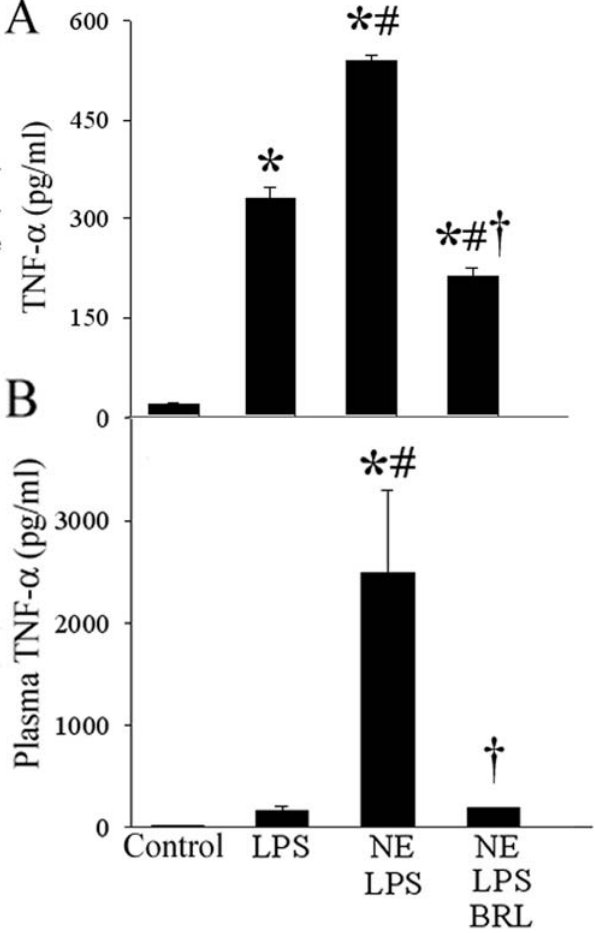
Figure 5. NE-mediated potentiation of LPS-mediated TNF- a release through the a 2A -AR. BRL-44408 maleate blocks TNF- a production in LPS-stimulated KCs after co-incubation with NE in vitro and in vivo . ( A ) Alterations in TNF- a release from cultured KCs 24 h after stimulation with NE (20 nM) and LPS (100 ng/ml), with or without BRL- 44408 (BRL, 1 m M). Data are presented as mean 6 SE (n=8) and compared by one-way ANOVA and Student-Newman-Keuls test. *P , 0.05 vs. Control; # P , 0.05 vs. LPS alone; { P , 0.05 vs. NE + LPS. ( B ) Alterations in plasma levels of TNF- a after administration of LPS (7.5 mg/kg, intra-peritoneal) and NE (20 m M NE for 2 h at 13 m l/min), with or without BRL-44408 (2.5 mg/kg BW, intra-portal). Data are presented as mean 6 SE (n=4–6) and compared by one-way ANOVA and Student-Newman-Keul’s method. *P , 0.05 vs. Control; # P , 0.05 vs. LPS alone; { P , 0.05 vs. NE +